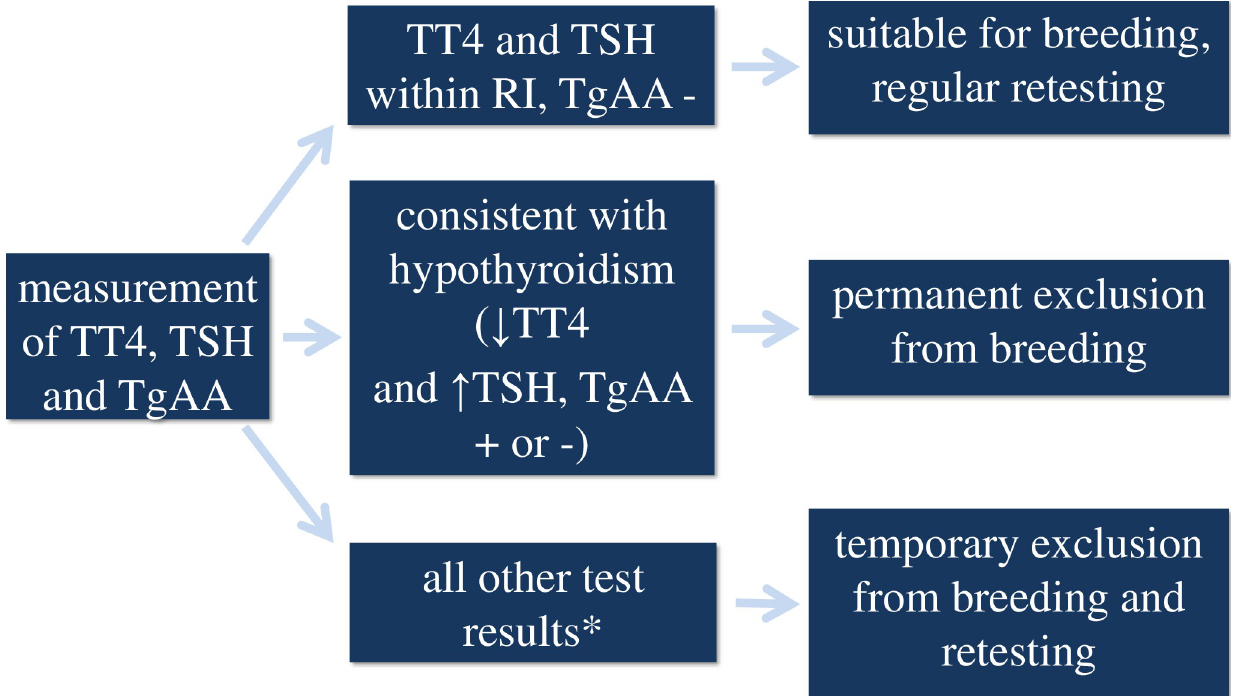
Fig 1. Thyroid screening scheme in Eurasian dogs participating in the screening program. TT4: total thyroxine concentration; TSH: thyrotropin concentration; TgAA: presence of thyroglobulin autoantibodies; RI: reference interval; +: positive; -: negative; " : greater than RI of the laboratory; # : less than RI of the laboratory. � See classification/characteristics of groups 3, 4, 5 and